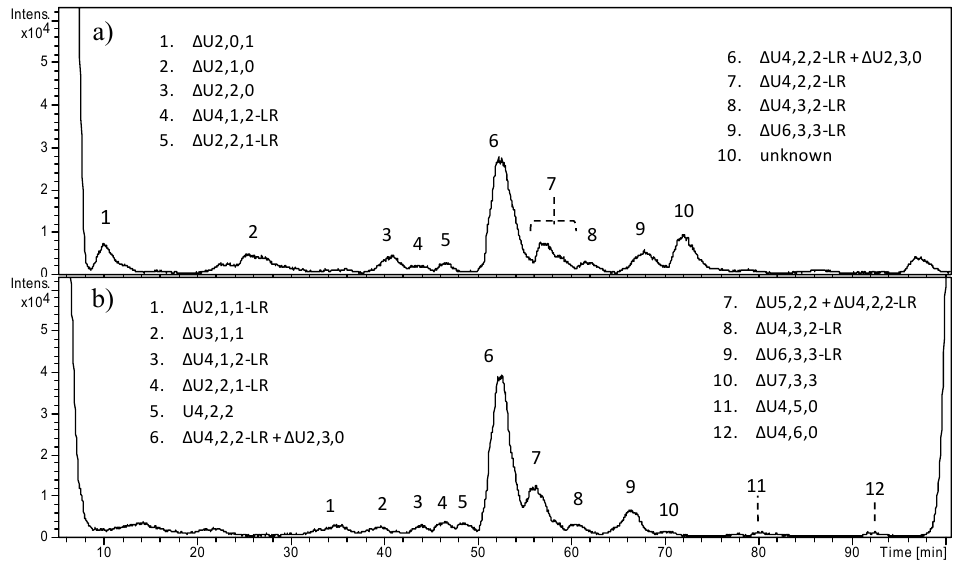
Figure 4. LC–MS profiles of heparinase digestion products from prepubescent healthy HS: ( a ) GRP2-A > 10 kDa, and ( b ) GRP2-B < 10 kDa. Oligosaccharides were identified by their mass/charge ratio ( m / z ) and labeled as follows: when a uronic acid (or a glucosamine) is present at both the RE and NRE, it is indicated by U (or A). LR indicates the tetrasaccharide linkage region G-Gal 2 -Xyl. Oligosaccharides for which an imprecise interpretation was found are labeled as